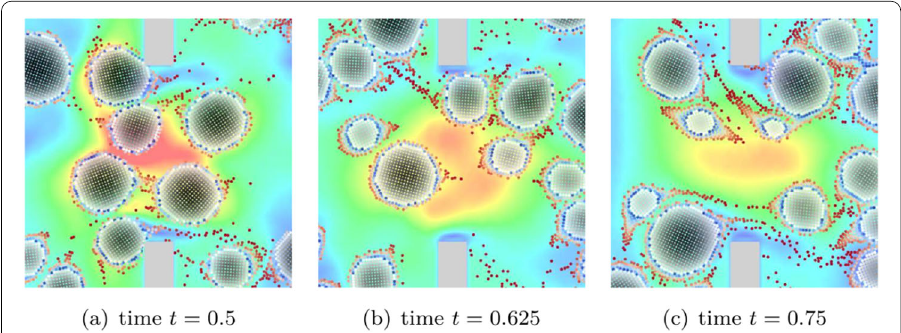
Fig. 16 Gastric disintegration of food boluses: detailed view of region at the mobile constriction for selected points in time. The concentration C is ranging from 0.0 (black) to C t = 0 . 8 (white) within the food boluses and from C t = 0 . 8 (blue) to 1.0 (red) within the chyme. In the background, the magnitude of the velocity field is ranging from 0 . 0 (blue) to 120 . 0